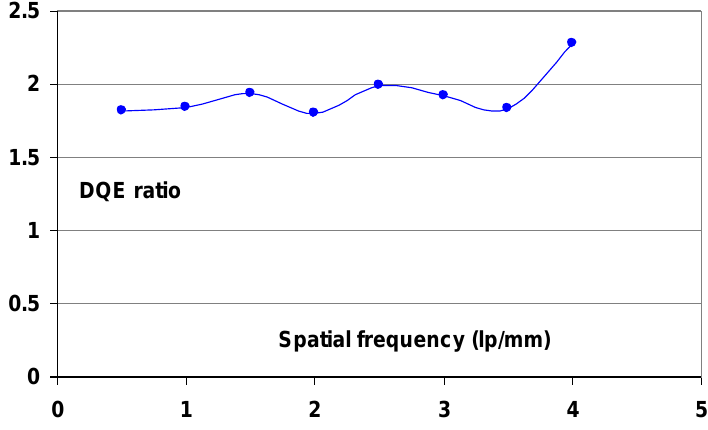
Figure 36. Ratio of NIP system-to-PIP system DQE (data from